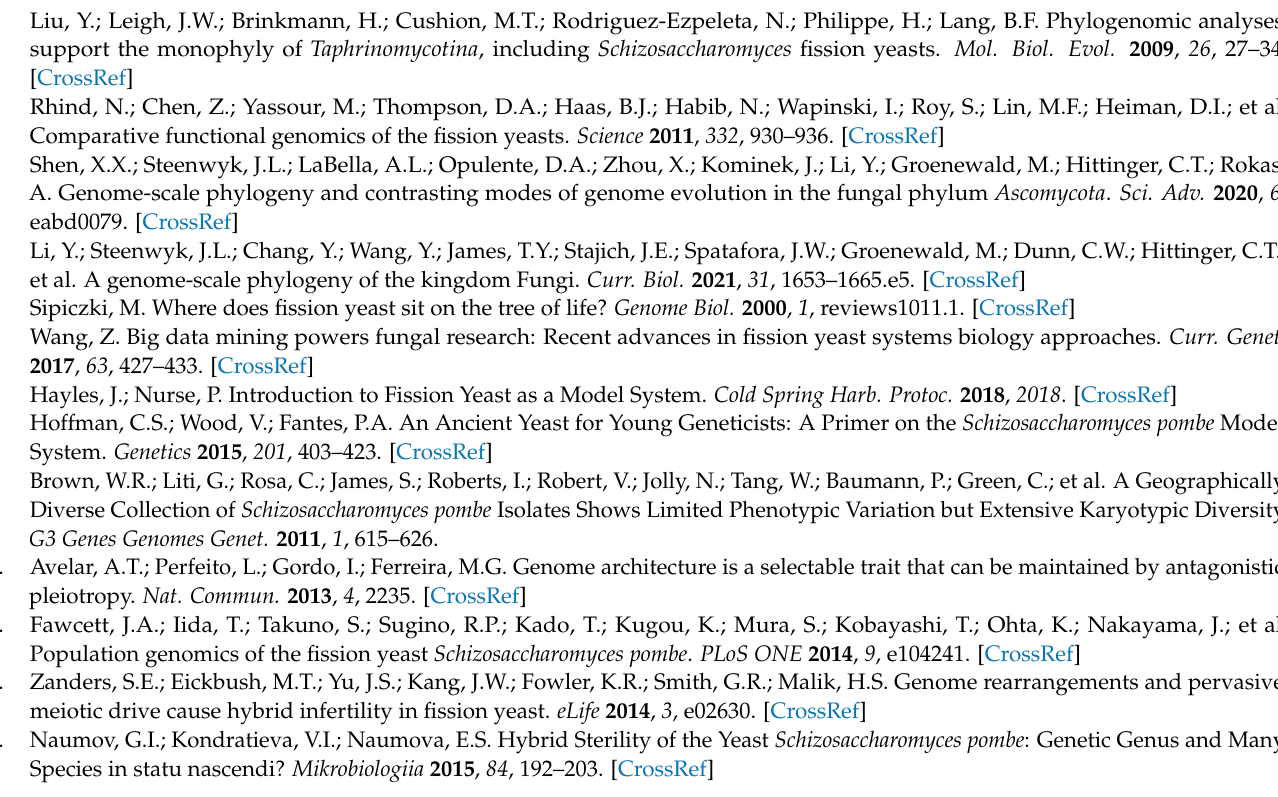
species; Table S14: Distribution of the genes from the main GO categories between aLCBs and NCBs; Table S15: Randomisation and statistical evaluation of the gene enrichments from the 31 candidate GO categories; Table S16: Rec12 cleavage site abundance in the aLCBs and in the NCBs; Table S17: Density of essential genes in the aLCBs and in the